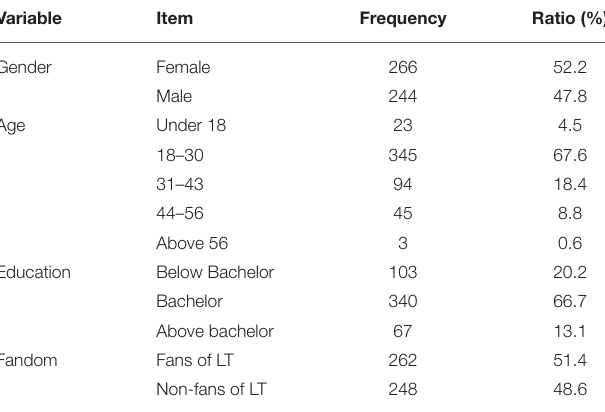
TABLE 2 | Demographic characteristics of sample ( N =